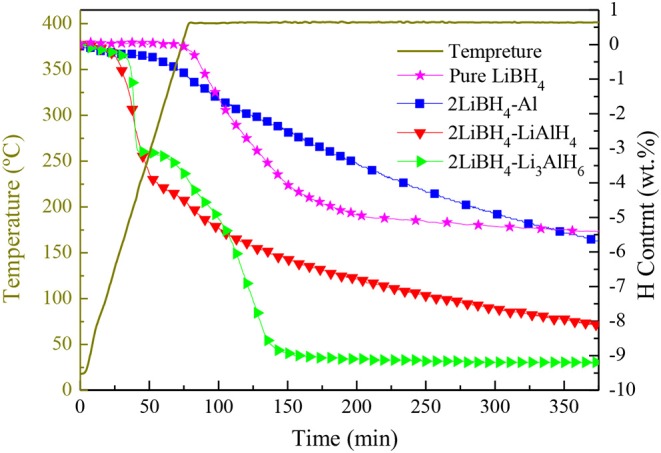
TPD curves of pure LiBH4, 2LiBH4-Al, 2LiBH4-LiAlH4, and 2LiBH4-Li3AlH6 samples.